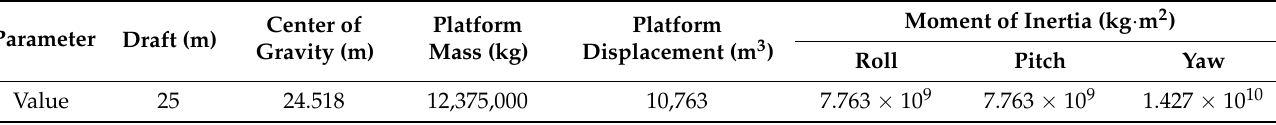
Figure 3. Schematic diagram of the novel floating platform model proposed in this paper. Table 2. Parameters of the novel floating platform proposed in this